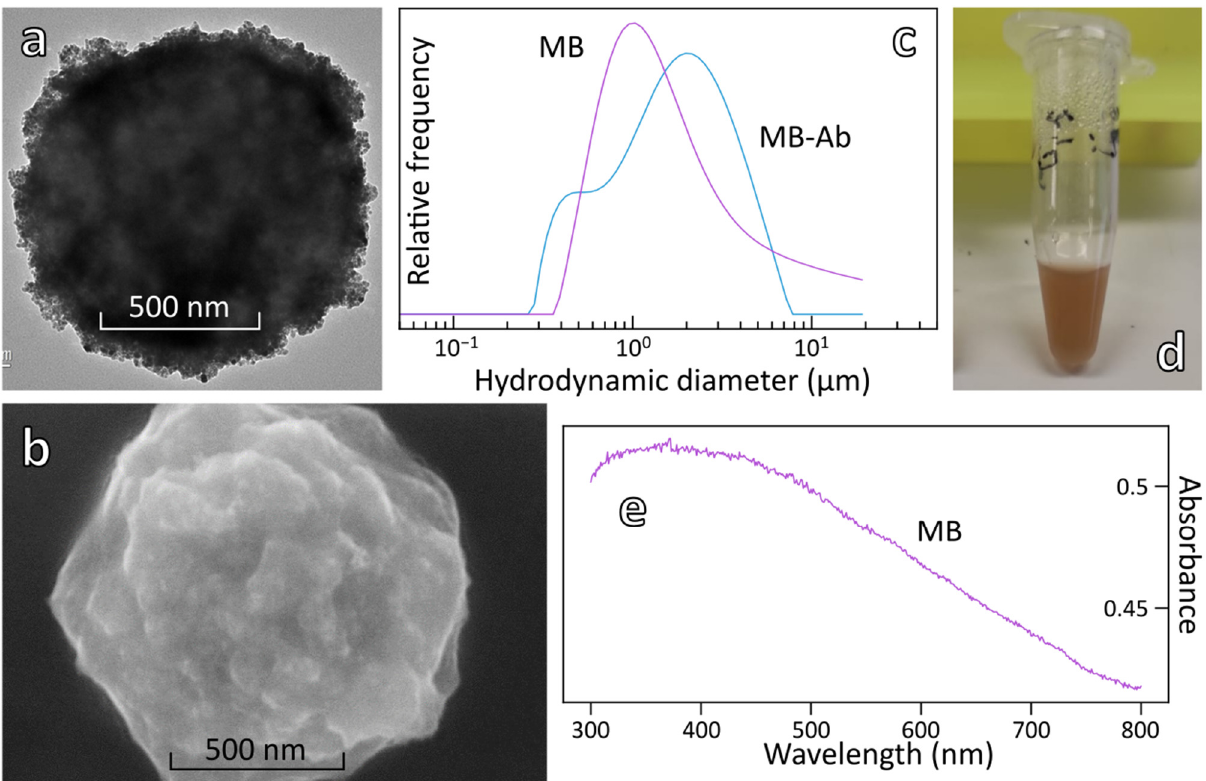
Figure 3. Physical characterizations of magnetic beads before and after conjugation of Ab, ( a ) TEM image (15,000×) and ( b ) SEM image of MB-Ab conjugate, (15 kV, 10.3 mm, 80,000×), ( c ) DLS measurements before (purple) and after (blue) conjugation of MB with antibodies, ( d ) Photograph of magnetic beads suspension with corresponding ( e ) UV–vis spectrum. Table 2. Hydrodynamic diameter (HD), polydispersity (PD), zeta potential and TEM size distribu- tion for bare (MB) and conjugated (MB-Ab).